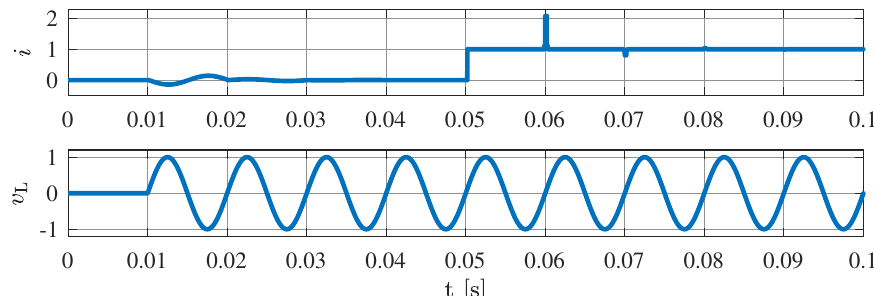
Figure 8. Response of the system to step reference at 0.05 s (output i and periodic disturbance v L ) for a conventional plug-in RC